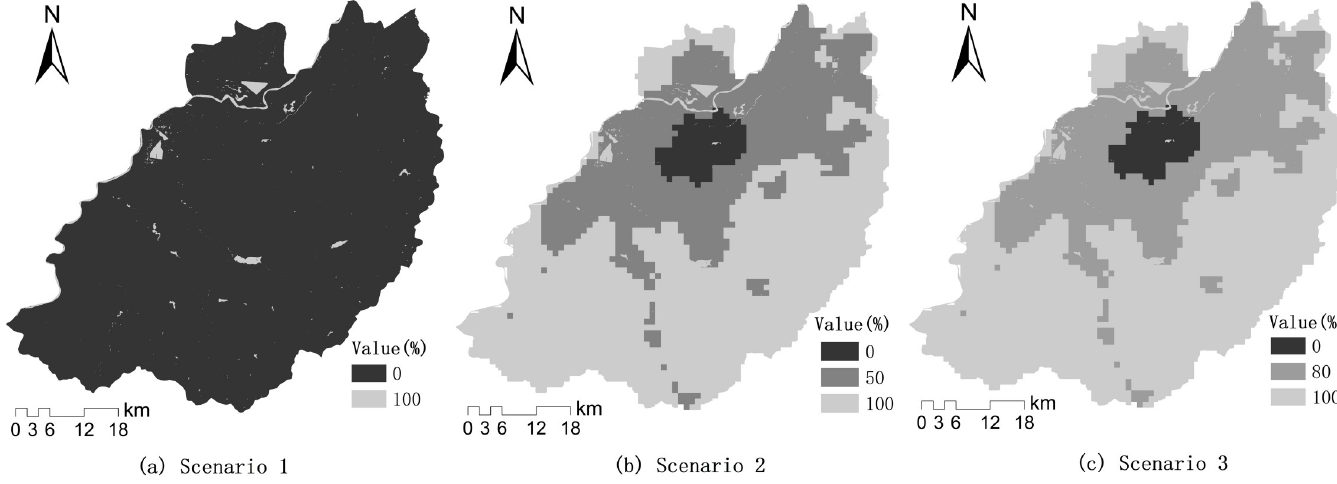
Fig 9. Exclusion layers for urban expansion scenarios.